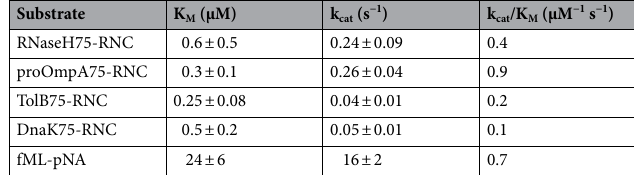
Table 1. Michaelis–Menten parameters of deformylation by PDF. Errors represent standard errors of the fit using the Michaelis–Menten equation (Fig. 1b). The deformylation of the formylated peptide fML-pNA was monitored photometrically (“Materials and